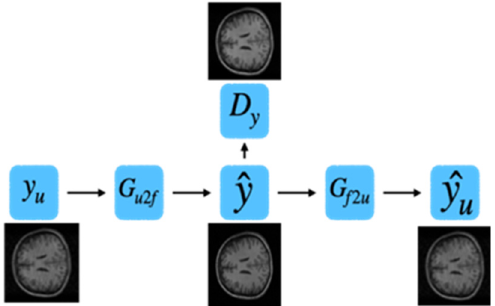
Figure 2. The discriminator D y was trained first by fully sampled image y . Then, generator G u 2 f and G f 2 u were trained in order. The input of G u 2 f is the undersampled image, and the output of G u 2 f is reconstructed image ˆ y . Then, ˆ y was fed into discriminator D y and generator G f 2 u simultaneously. The discriminator was expected to distinguish y and ˆ y . For G f 2 u , its output should be the reconstructed zero-filled images ˆ y u . We forced ˆ y u to be similar to y u by minimizing the value of (cid:107) ˆ y u − y u (cid:107) 1 l .